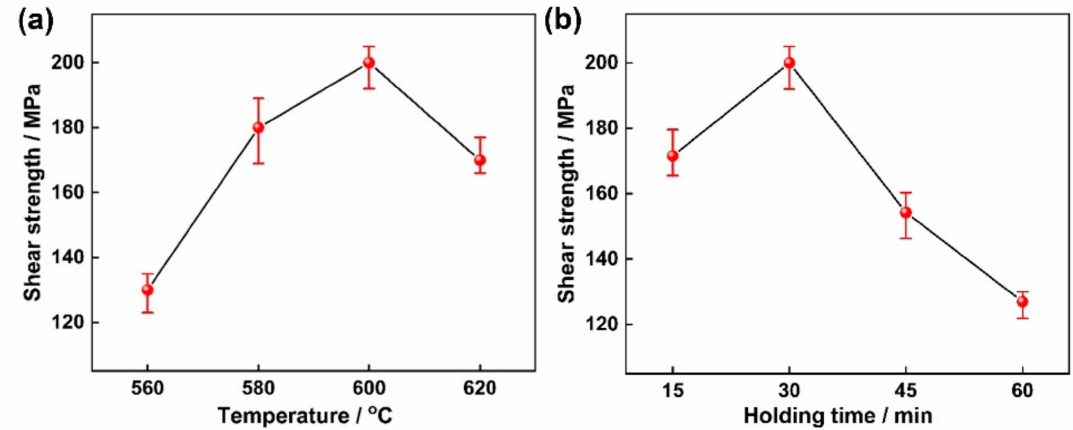
Figure 7. Effect of the brazing parameters on mechanical properties of brazed joints. ( a ) Brazing temperature; ( b ) Holding time.